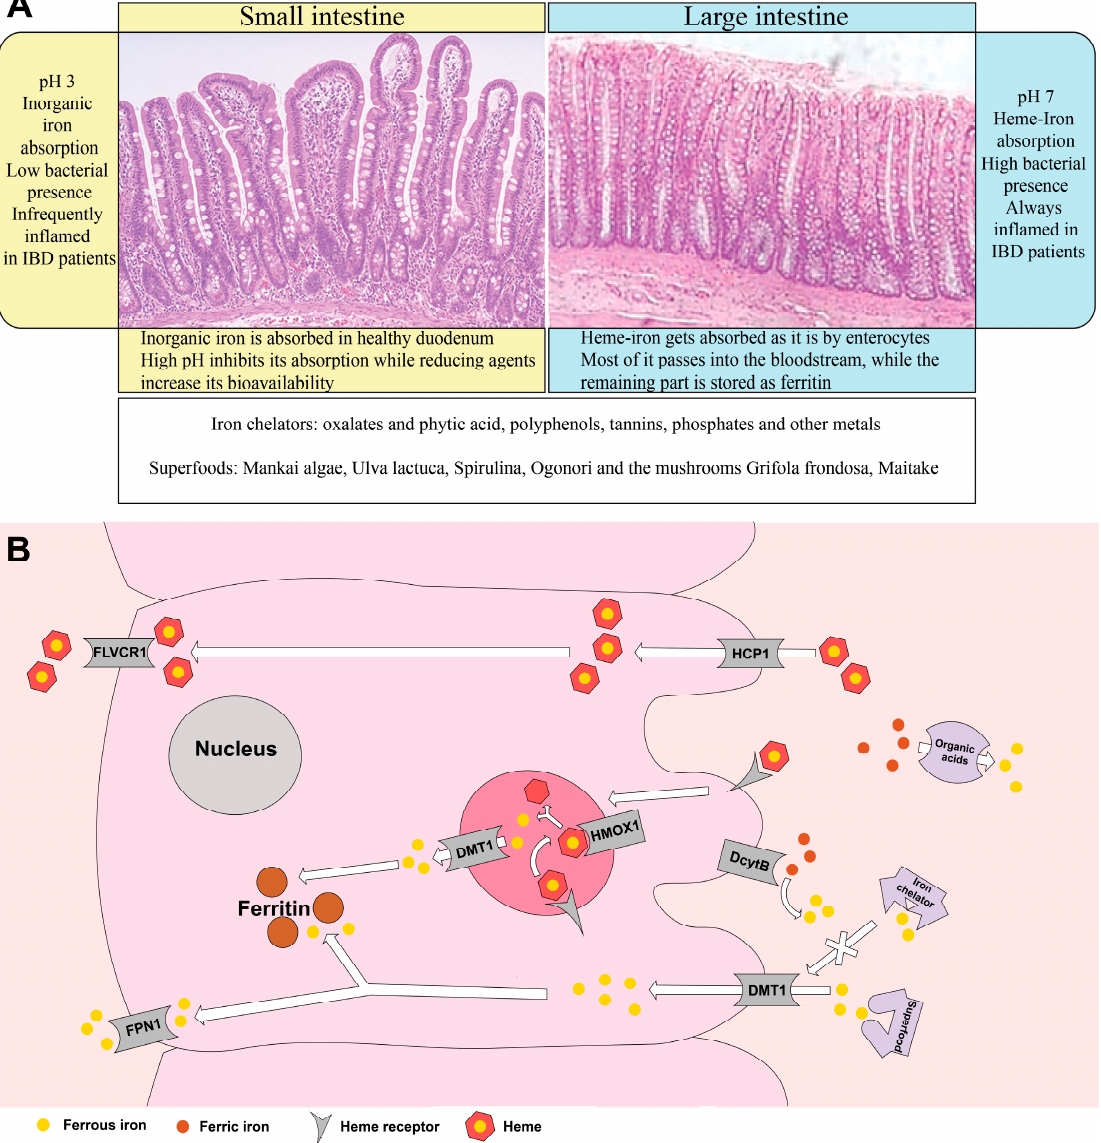
Figure 1. ( A ) Influence on iron absorption of pH, intestinal tract, and nutrients. Many nutrients and inorganic metals influence iron bioavailability and can increase or decrease its absorption; superfoods are often rich in iron, proteins, and vitamins. A Mediterranean diet supplemented with Mankai smoothies, for example, provides the right amount of daily iron. Superfoods also show antioxidant, immunomodulatory, and anti-inflammatory properties. ( B ) Iron absorption is influenced by food contents. Heme-iron is easier to absorb and can be directly absorbed or dissociated into ferrous ions and porphyrinic ring. Ferric ions need to be reduced to ferrous ions either by organic acids in the intestinal lumen or by DcytB and then they can be transported by DMT1 in the enterocyte and into the bloodstream by ferroportin. Intracellular iron can be also stored as ferritin. Iron chelators “steal” iron ions from the cells as opposed to superfoods that provide and “liberate” iron ions to the cells. (FLVCR1: Feline Leukemia Virus Subgroup C Receptor-Related Protein 1; HCP1: Heme Carrier Protein 1; DMT1: Divalent Metal Transporter 1; HMOX1: Heme Oxygenase 1; DcytB: Duodenal Cytochrome B; FPN1: Ferroportin